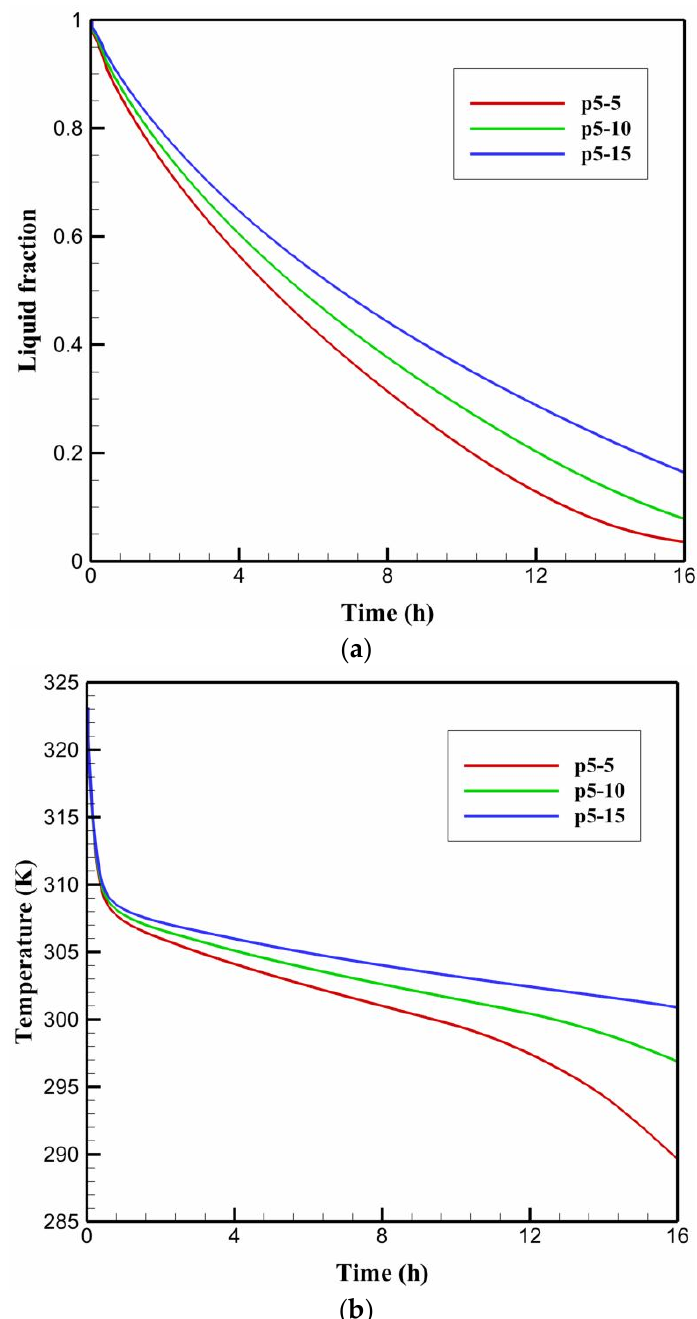
Figure 13. The time-wise variation of ( a ) liquid-fraction profile, and ( b ) average temperature for the PCM solidification with the cases of P5-5, P5-10, and P5-15. Table 8. The energy removal rate during solidification in the cases of P5-5, P5-10, and P5-15.